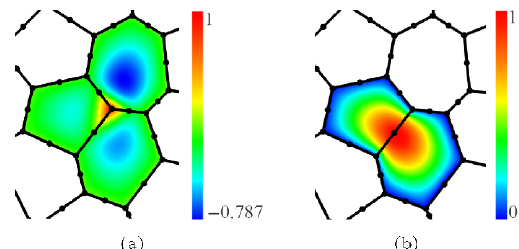
Fig. 3 Merged quadratic serendipity element basis functions. Values of basis functions are color-coded as per the color bars. (a) Merged quadratic basis associated with a vertex. (b) Merged quadratic basis associated with an edge